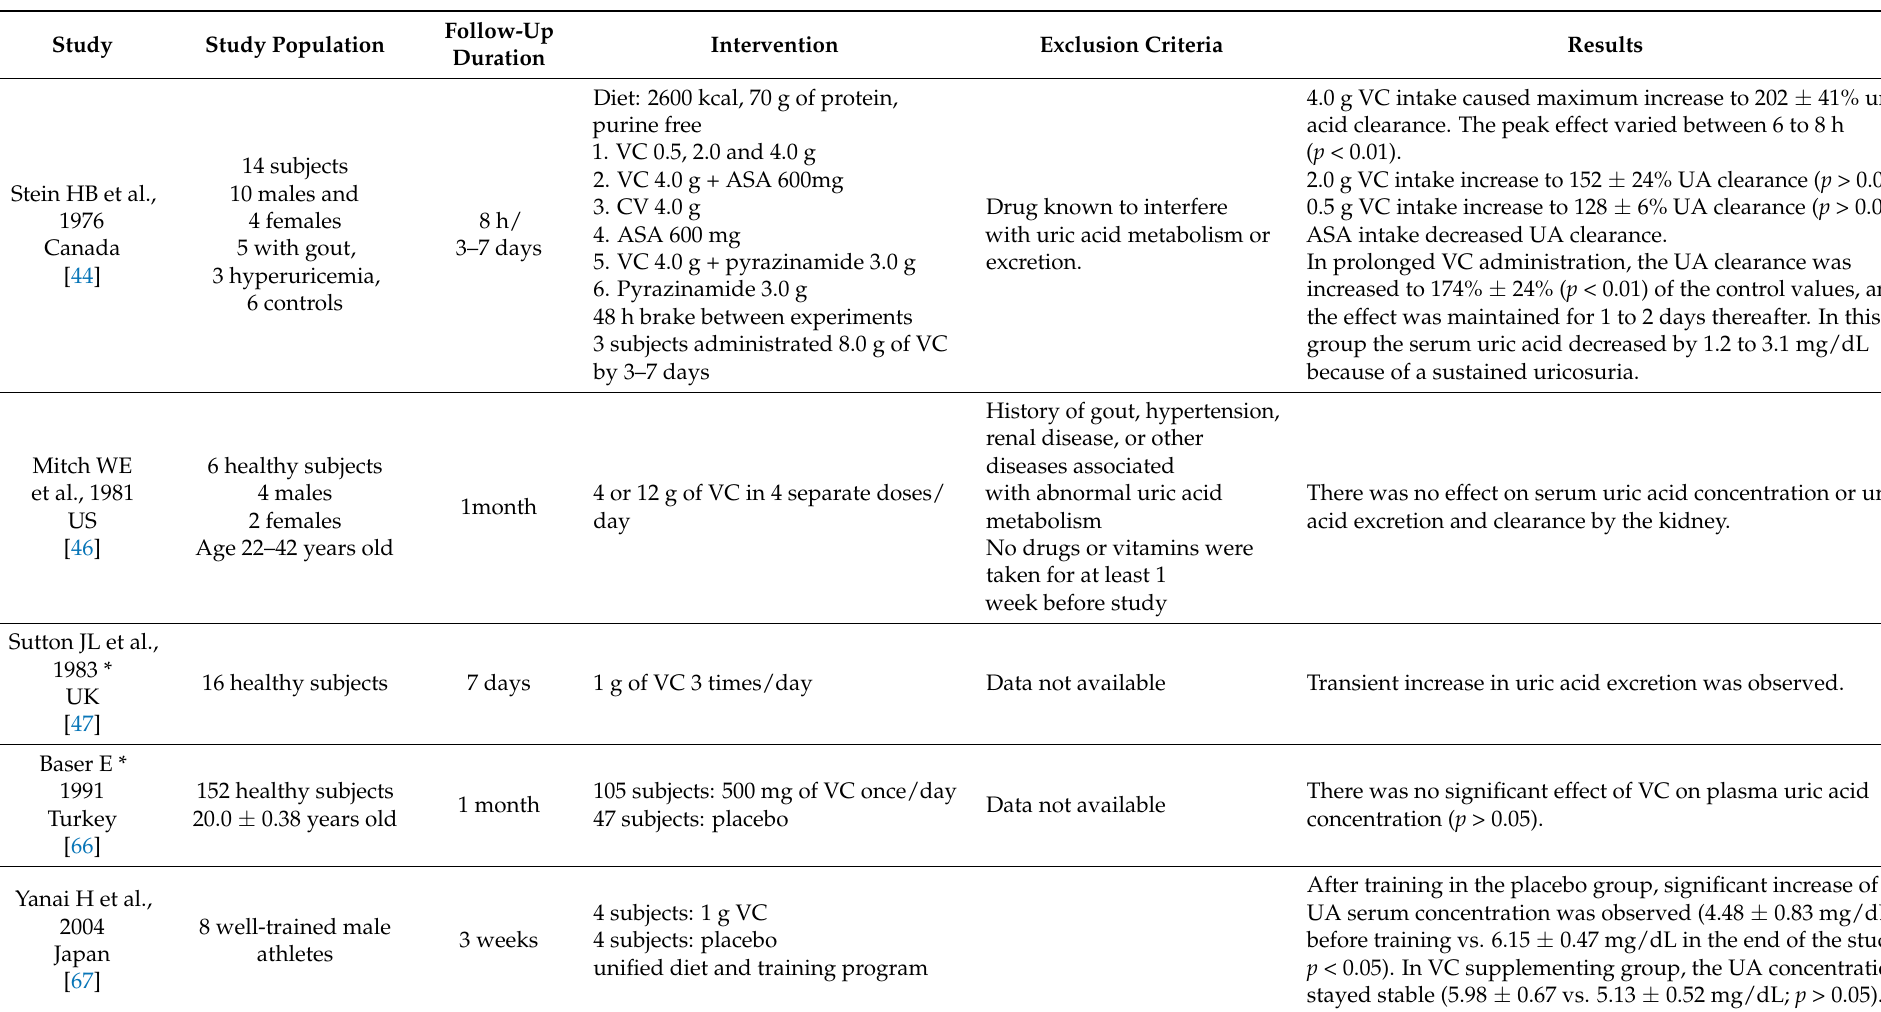
Table 3. Interventional studies discussing the dependence of vitamin C supplementation and the risk of hyperuricemia, gout, and uricosuric